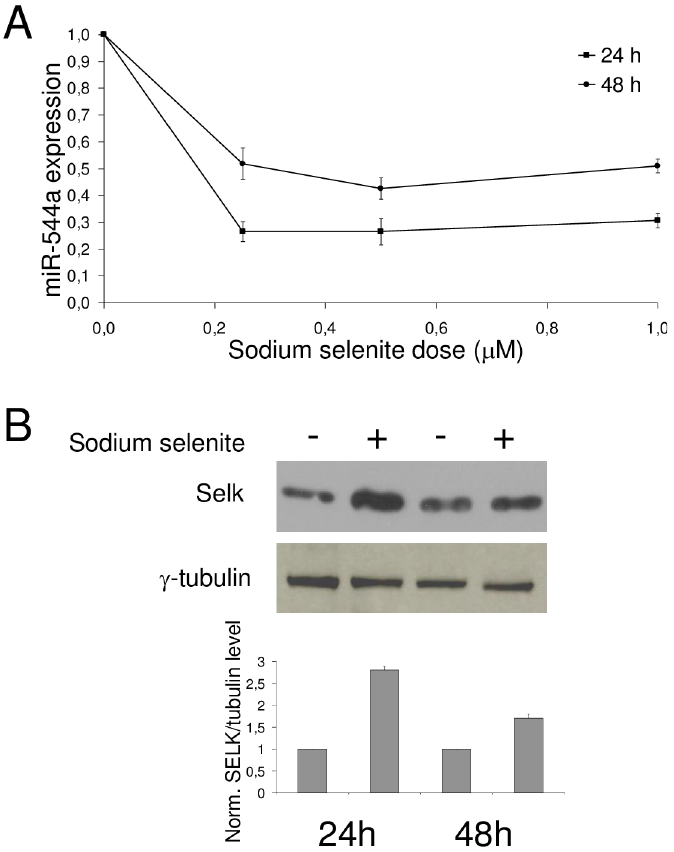
Fig 5. Effect of sodium selenite on miR-544a expression and SELK (A) Cells were cultured for 24 h and 48 h in standard condition or in presence of increasing sodium selenite doses; miR-544a expression was determined by RT-qPCR and reported as fold change of expression in treated samples vs untreated ones. (B) Upper panel, representative Western blot analysis of protein extracts from cells cultured in absence (-) or presence (+) of 1 μ M sodium selenite for 24h and 48 h; lower panel, quantification of protein bands; values represent the mean ± s.d. of three independent